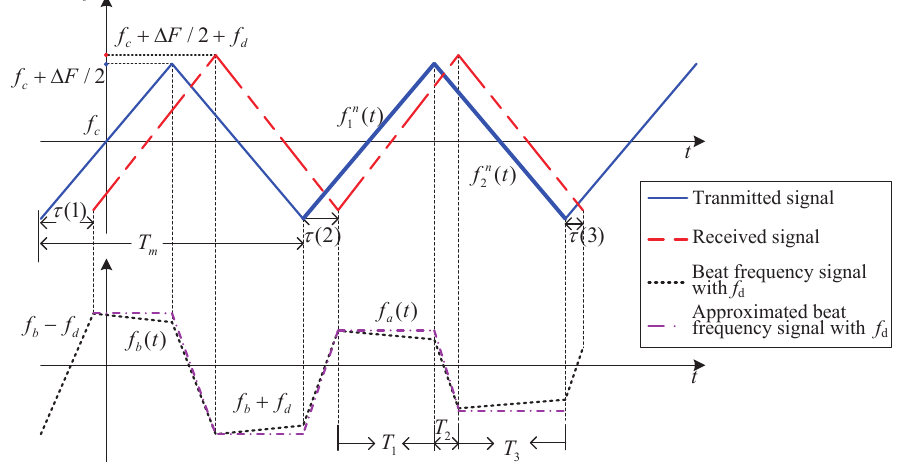
Figure 2. Instantaneous frequency of the transmitted and received signals with relative motion between sensor and target.